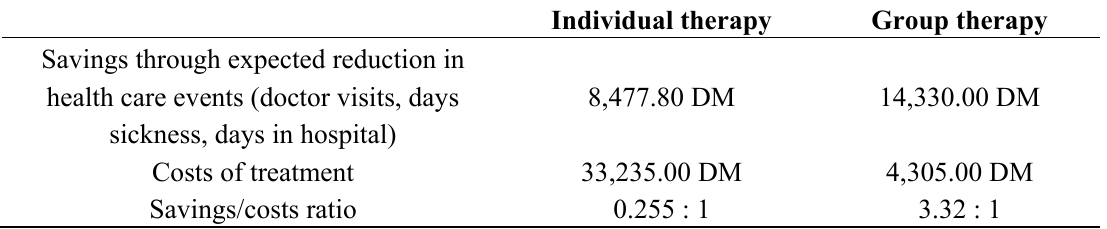
Table 1. Savings accrued as a result of individual and group psychotherapy in the first two years after completion of therapy (table taken from Breyer et al. 1997 with kind permission from the